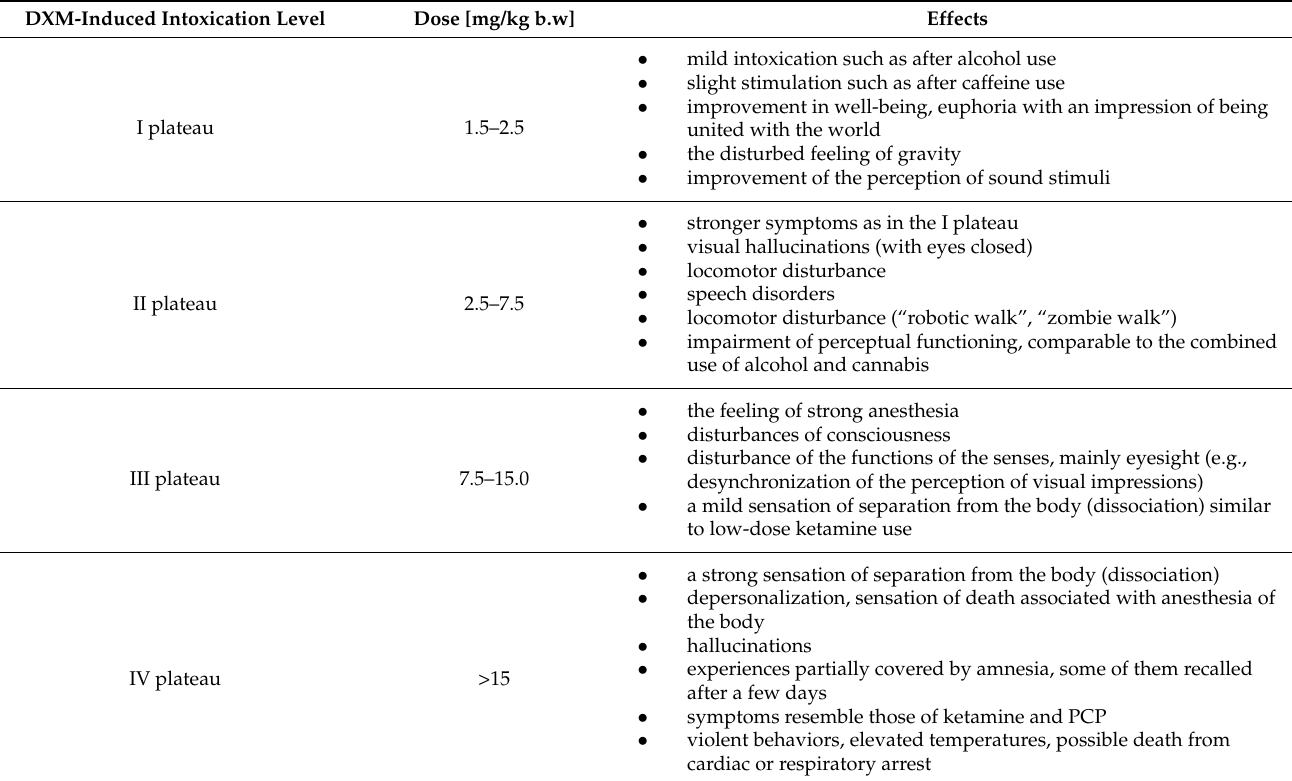
Table 1. Dextromethorphan intoxicating levels (adapted with permission from [36]. 2008, Krajowe Centrum Przeciwdziałania